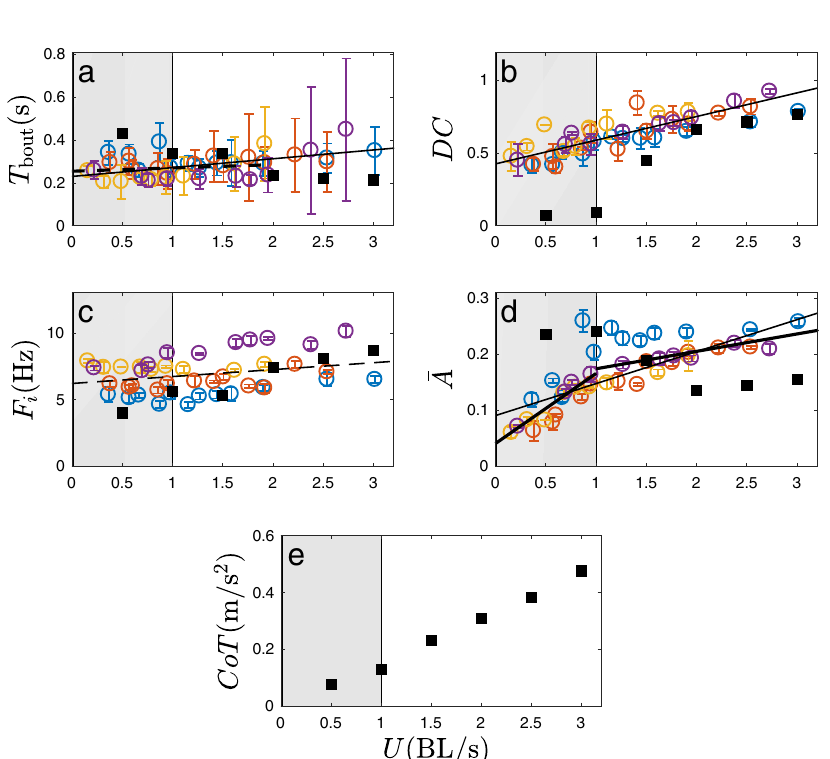
Fig. 2 Burst-and-coast properties and cost of transport as a function of the imposed swimming speed U in body length per second (BL/s). a Bout duration T bout . b Duty cycle DC = T burst / T bout . c , d Frequency and peak-to-peak amplitude of the tail beat during a bursting phase, respectively. e Cost and transport, CoT. Different marker colors correspond to different individuals. Error bars are standard deviations. The optimization results obtained from the burst-and-coast model based on 3D numerical simulations of an arti fi cial swimmer are superimposed to the experimental data in fi lled black square symbols ( ■ ). Thick solid and dashed straight lines correspond to the linear mixed-effects model fi ts having, respectively, statistically signi fi cant and insigni fi cant slopes. Panels ( a ) and ( d ) show global fi ts (thinner lines) and local piece-wise fi ts (thicker lines). See Supplementary Information (Part 1) for the source experimental data points for each fi